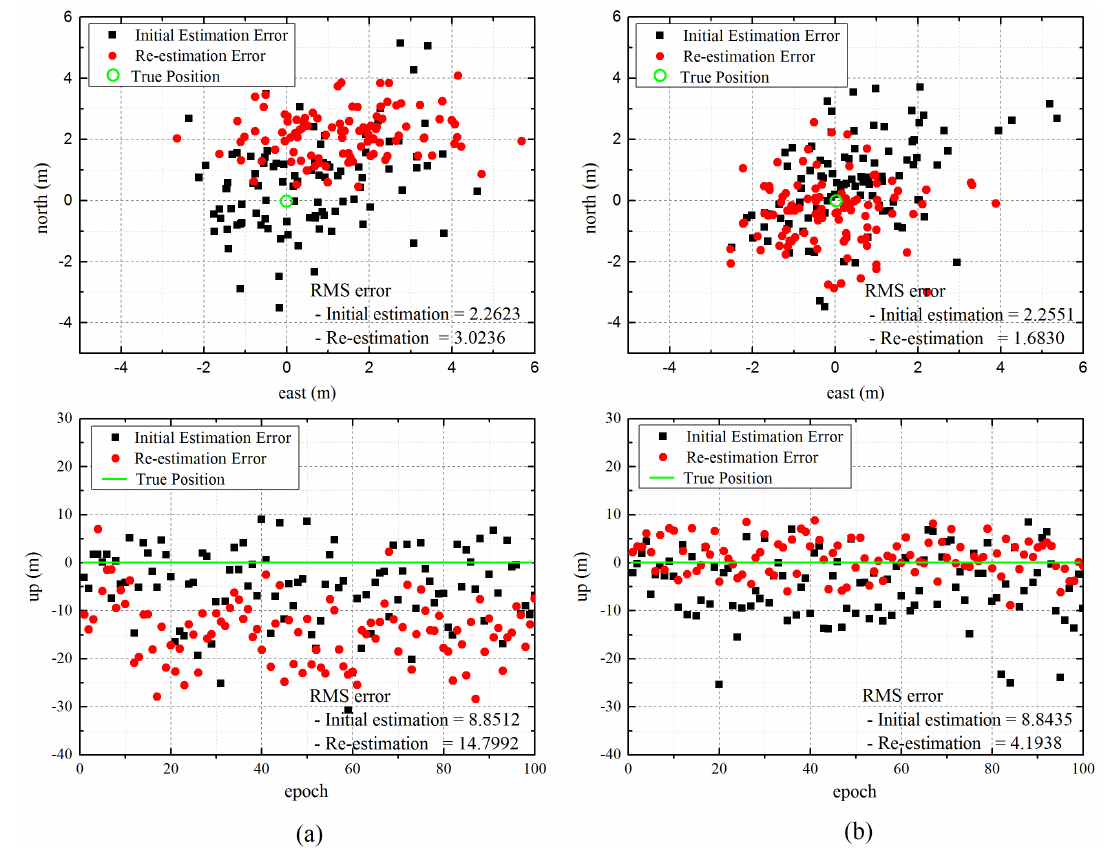
Figure 5. Re-estimation errors of the user for direct and virtual measurements. ( a ) Results for direct measurement; ( b ) Results for virtual